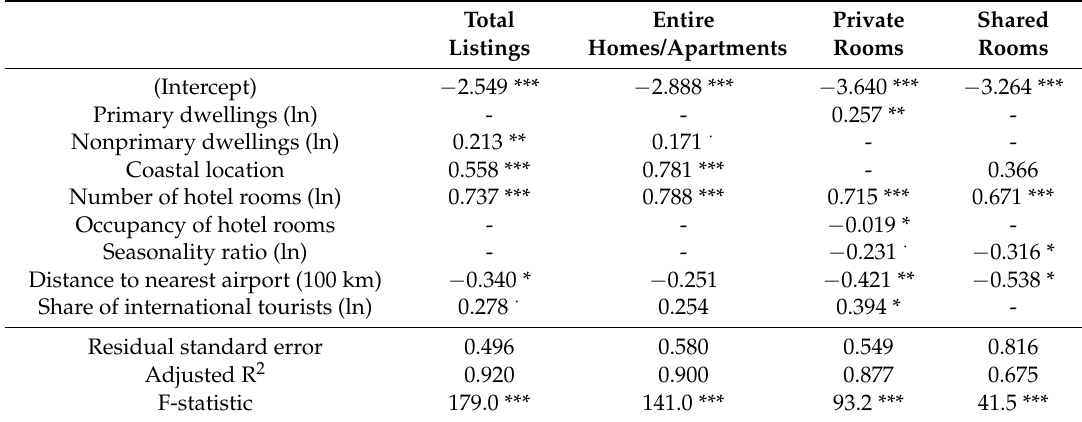
Table 7. Final linear models for tourist areas/sites (N =